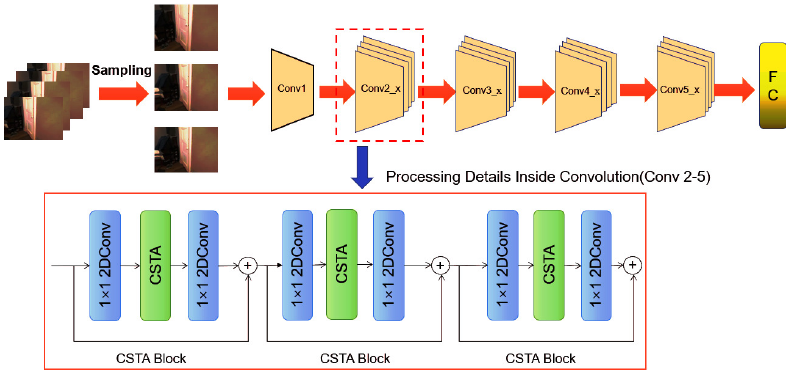
Figure 2. Framework of CSTANet.